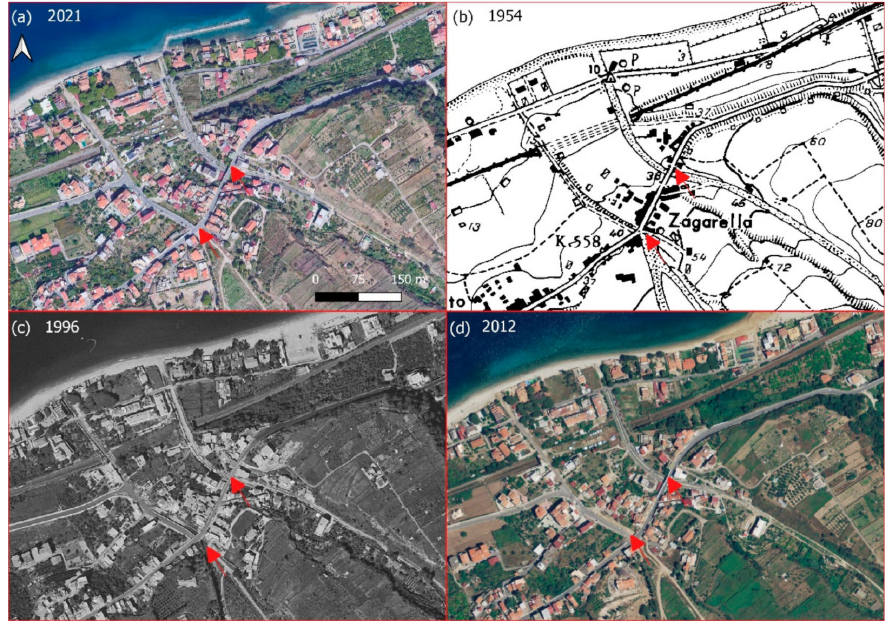
Figure 11. The Zagarella and Piria rivers. ( a ) An image from Google Earth from September 2021. ( b ) The CASMEZ cartography from 1954. ( c ) The orthophoto from 1996. ( d ) The orthophoto from 2012. The arrows identify the section where the riverbed was transformed into a street.